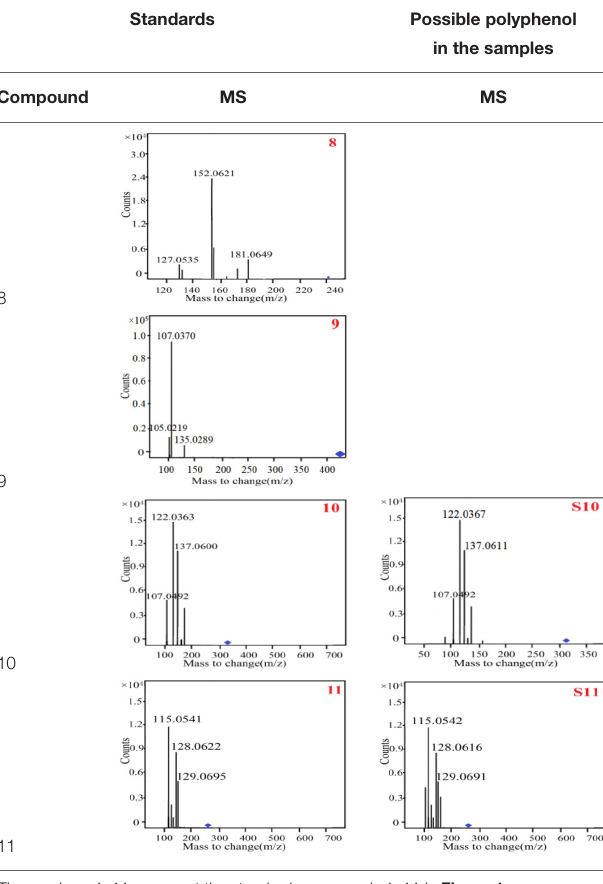
TABLE 3 | The MS/MS spectrum of the standards and the possible polyphenols obtained by Q-TOF-MS